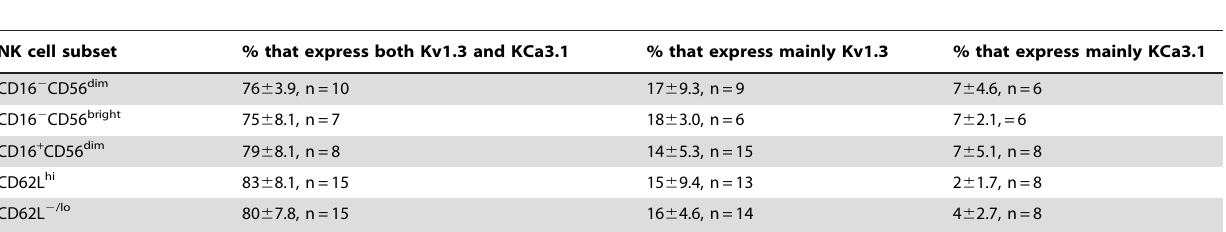
Table 1. Percentages of CD3 2 CD56 + NK cells that express Kv1.3, KCa3.1, or both channels after cell-sorting of different populations based on cell surface marker expression.